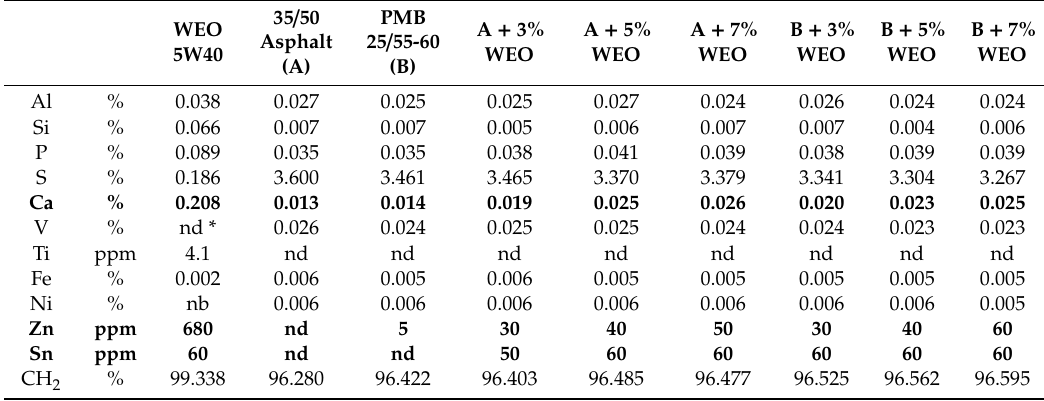
Table 2. Chemical composition of the studied